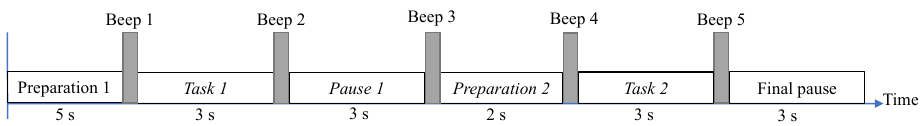
Figure 6. Time sequence of each trial. The total trial duration was established at 19 s, where 6 s were used for the related MI tasks: the left fist as Task 1 (3 s) and the right fist as Task 2 (3 s). The neutral or reference action was taken as the final pause (3 s) to have an equal number of samples per class.